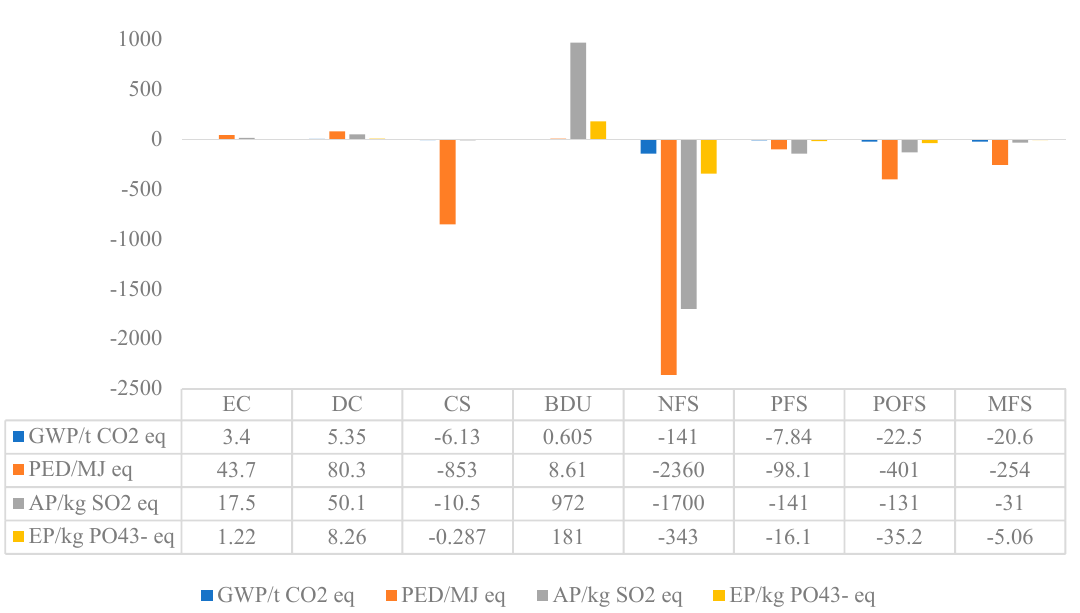
Figure 5. Primary GWP, PED, AP and EP equivalents of the system operation and maintenance stage. Biogas digestate utilization (BDU) accounted for the highest proportion of AP (972 kg SO 2 eq) and EP (181 kg PO 43 eq), this may be due to the high NH 3 and phosphate field emissions along with the use of digestate. According to Sommer and Hutchings and Ram í rez Arpide et al., field applied organic matter contributes significantly to the emission of NH 3 from agriculture [44]. In contrast, the full use of digestate substituted a large quantity of chemical fertilizers, the substitution consists of